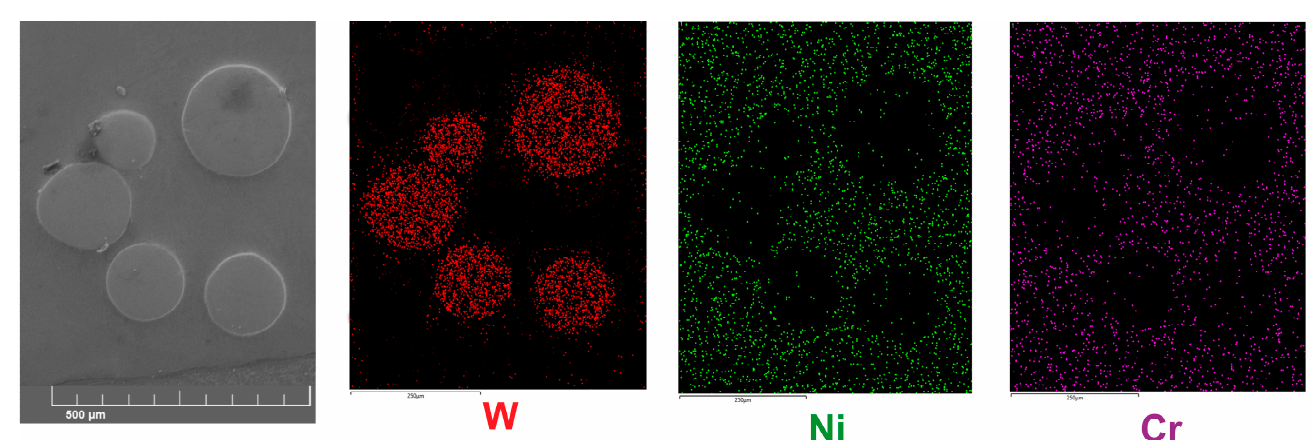
Figure 7. SE image and EDS mapping of tungsten, nickel, and chromium performed for a laser-alloyed layer produced with a laser beam power of 1.3 kW.